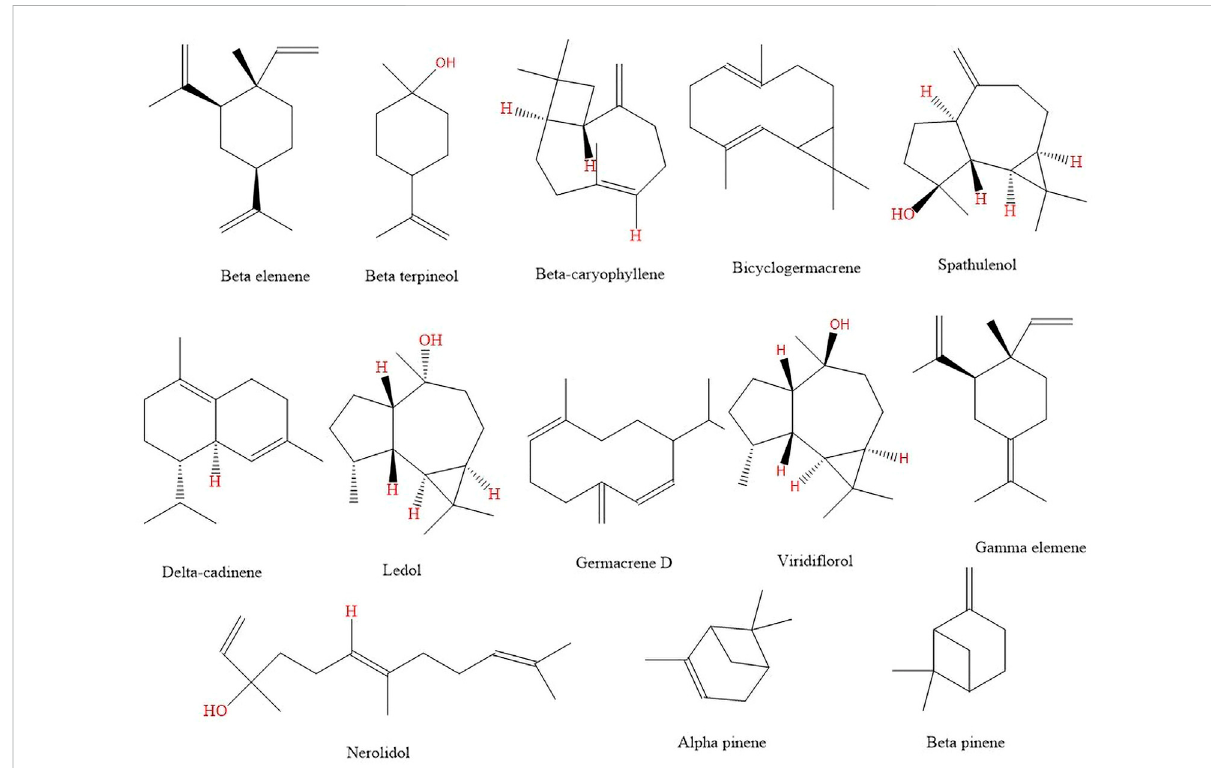
FIGURE 4 Chemical structures of majority volatiles constituents isolated from Baccharis dracunculifolia .